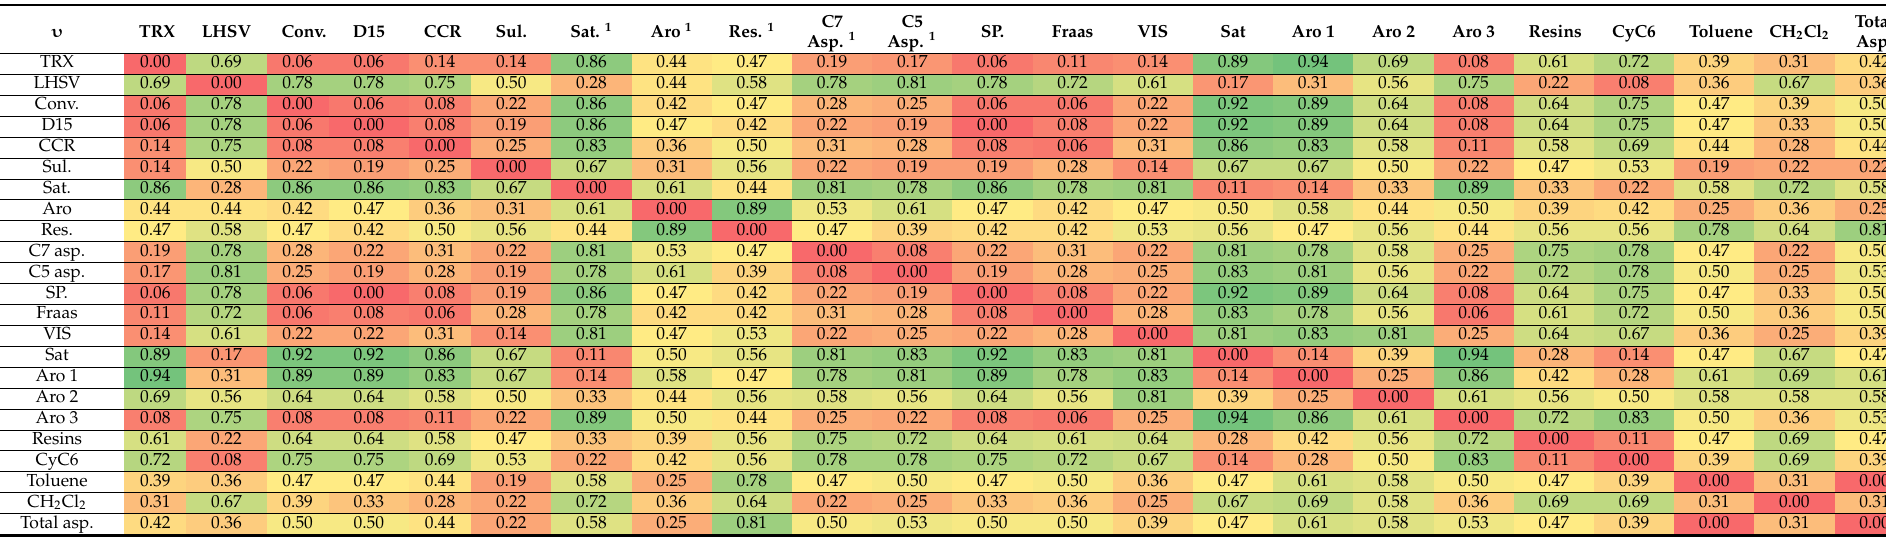
Table 9. υ -Value of the ICrA evaluation of relations between bulk properties, LNB SARA, SAR-AD characteristics of H-Oil VTB, and reaction